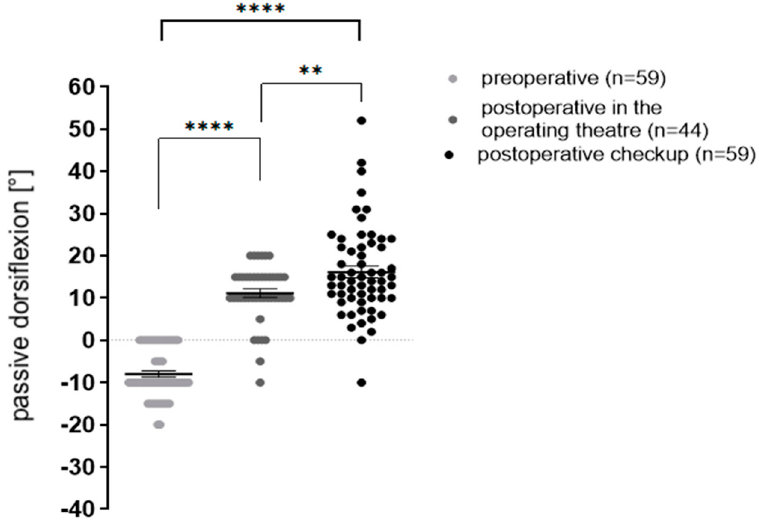
Figure 3. Dorsiflexion before, directly after surgery and at follow-up. (** p < 0.007; **** p < 0.0001) Preoperative ankle dorsiflexion was -8° ± 5.9° and increased significantly to 11.1° ± 6.7° immediately after surgery. At follow-up (12.26 ± 7.95 months after surgery), an addi- tional improvement to 16.2° ± 10.7° could be noted. (** p < 0.007; *** p < 0.0001, **** p < 0.0001). Data were analyzed by one-way analysis of variance and unpaired Students’ t - test. Patients’ subjective satisfaction concerning strength in the lower limbs, range of mo- tion and gait pattern showed a subjective improvement. Subjective gait pattern improve- ment was noted in 57 feet (40 patients). One ambulatory child was not satisfied with the surgical result (Table 2). Table 2. Subjective satisfaction at follow-up. Extremely Satisfied [%]